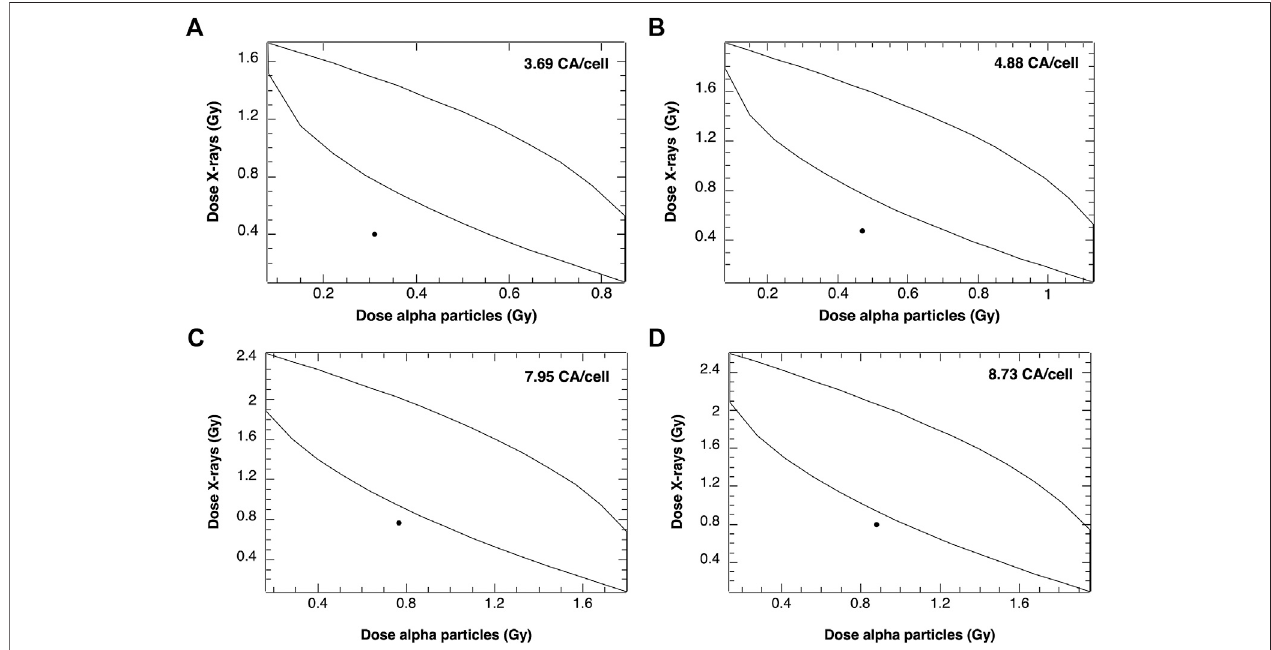
FIGURE 7 | Envelopes of additivity calculated for 4 selected frequencies of chromosomal aberrations (CA), from mixed beams composed of 50:50 alpha particles and X-rays: A: 3.69 CA/cell, B: 4.88 CA/cell, C: 7.95 CA/cell and D: 8.73 CA/cell. The mixed beam doses were 0.71 Gy (A) , 0.94 Gy (B) , 1.53 Gy (C) , and 1.68 Gy (D) .